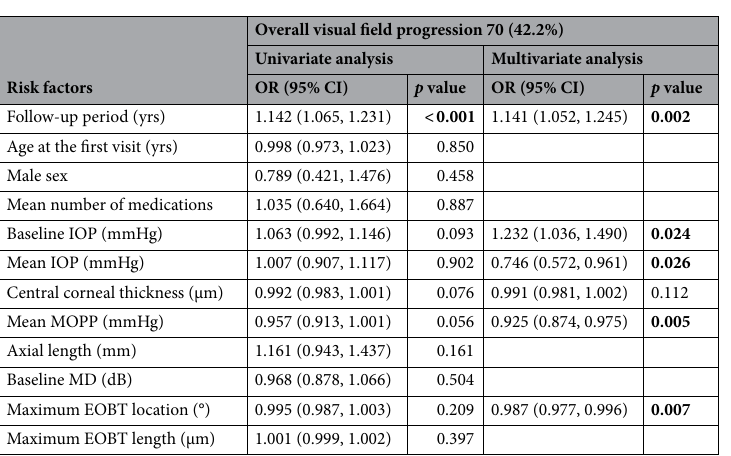
Overall visual field progression 70